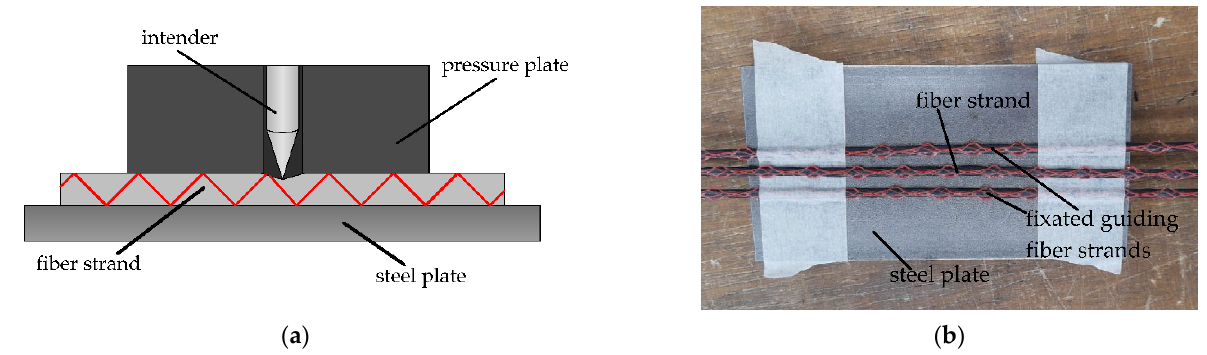
Figure 10. ( a ) Close-up schematic of the Shore hardness testing. ( b ) One fiber strand fixed on the steel plate for testing.